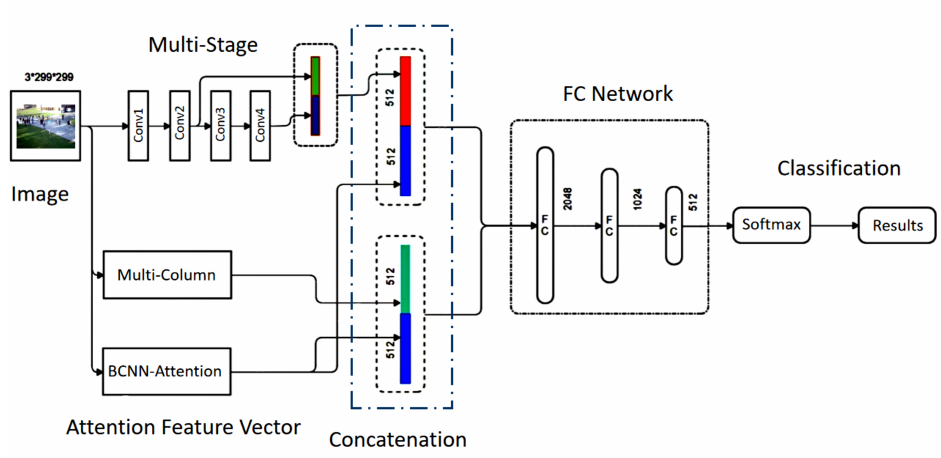
Figure 1. The network architecture of the proposed